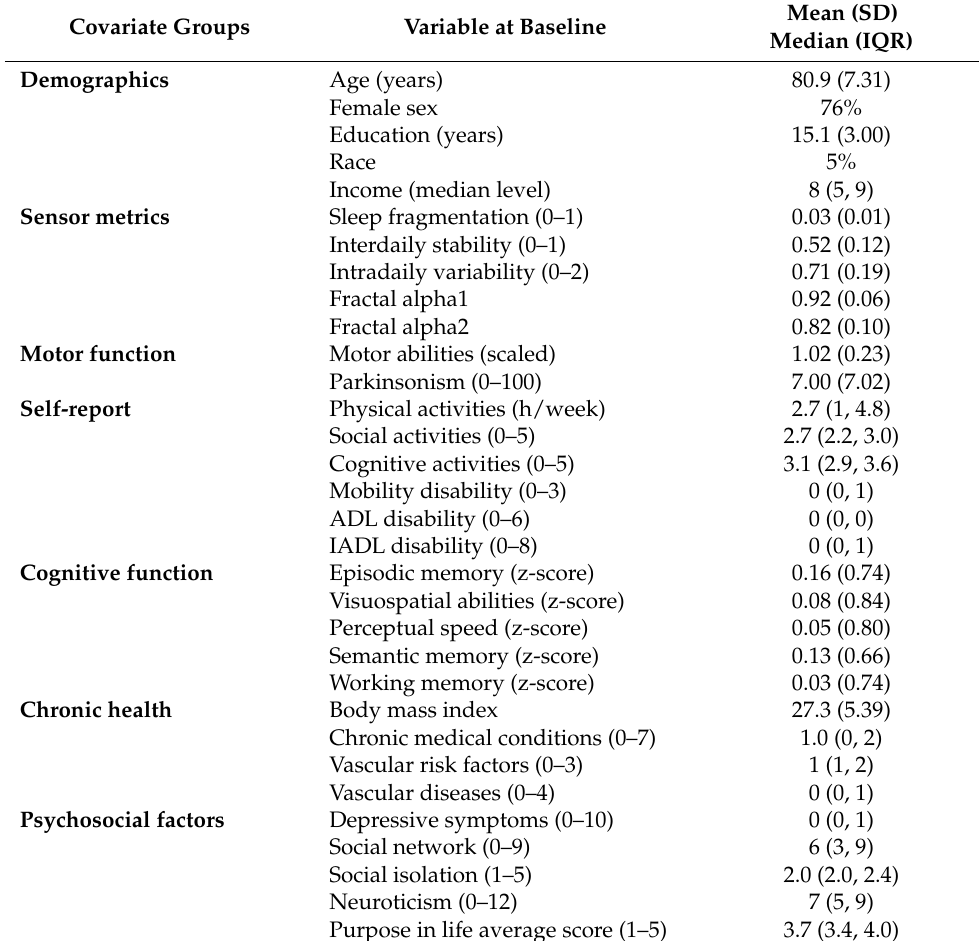
Table 1. Baseline characteristics of the analytic cohort (N = 1083)